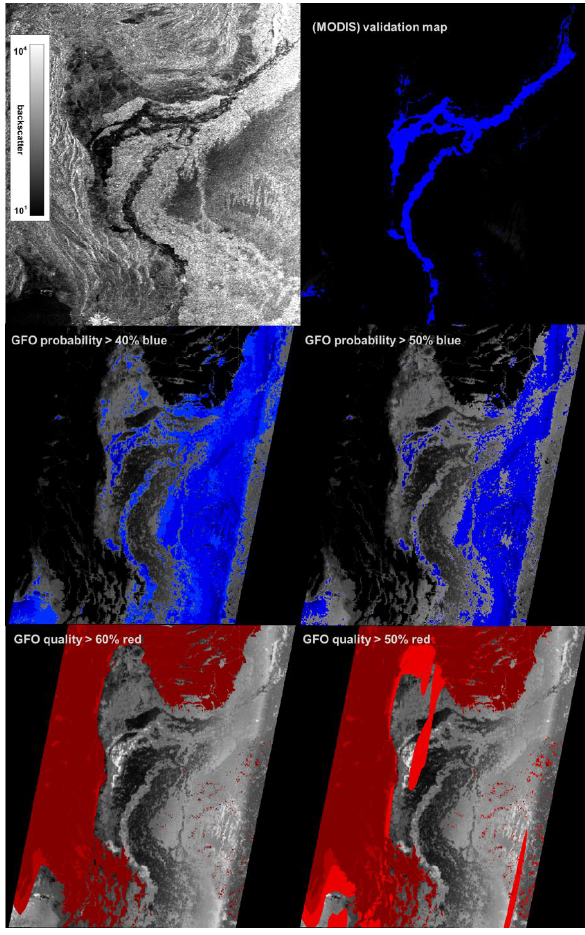
Figure 10. Top left: backscatter Envisat-ASAR GM image of Pakistan, Sukkur, on August 29, 3 Fig. 10. Top left: backscatter Envisat-ASAR GM image of Pakistan, Sukkur, on 29 August 2010. Top right panel: MODIS validation 2010. Top right: MODIS validation map. Middle left and right: GFO probabilities thresholded 4 map. Middle left and right panels: GFO probabilities are applied for higher than 40% and 50%. Bottom left and right: GFO quality indicators higher than 60% 5 at a threshold for higher than 40 and 50%. Bottom left and right and 50%. 6 panels: GFO quality indicators higher than 60 and 50%.